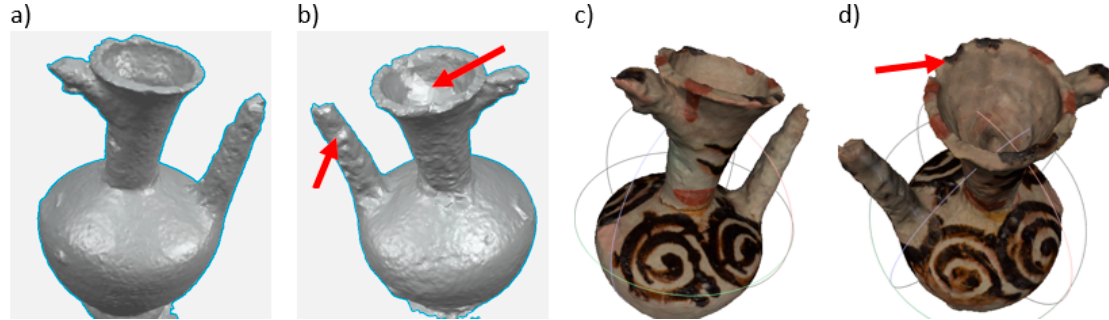
Figure 10. Sample photos after post-processing.